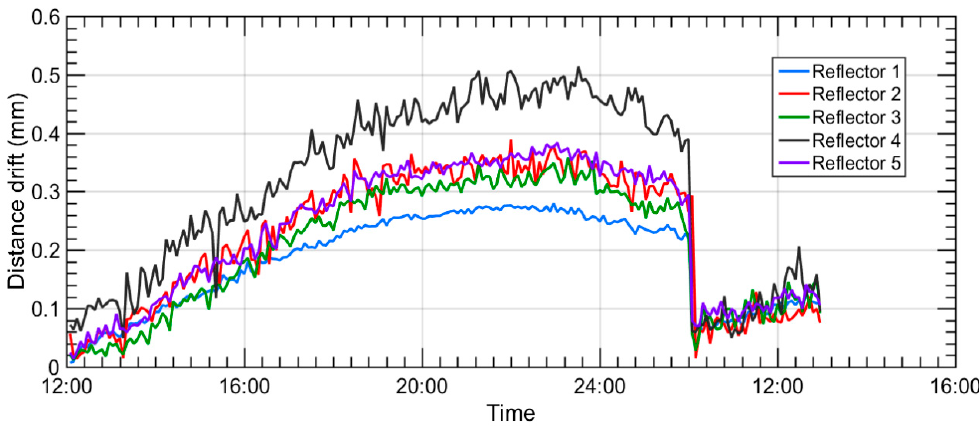
Figure 7. Floor movement assessment for the TMA RPE assessment.